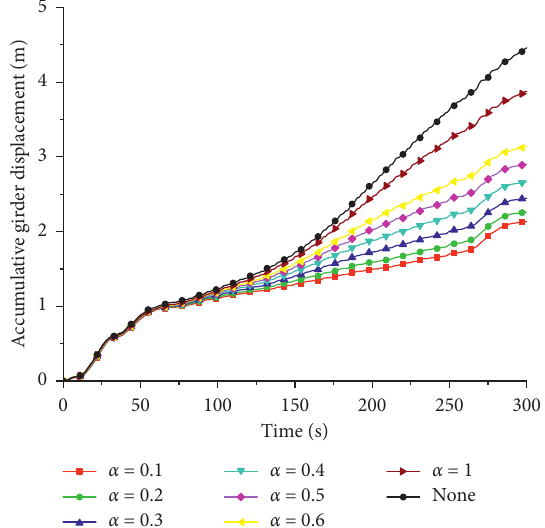
Figure 28: Time history curve of accumulative girder displacement ( C � 5000kN/ ( m/s ) α